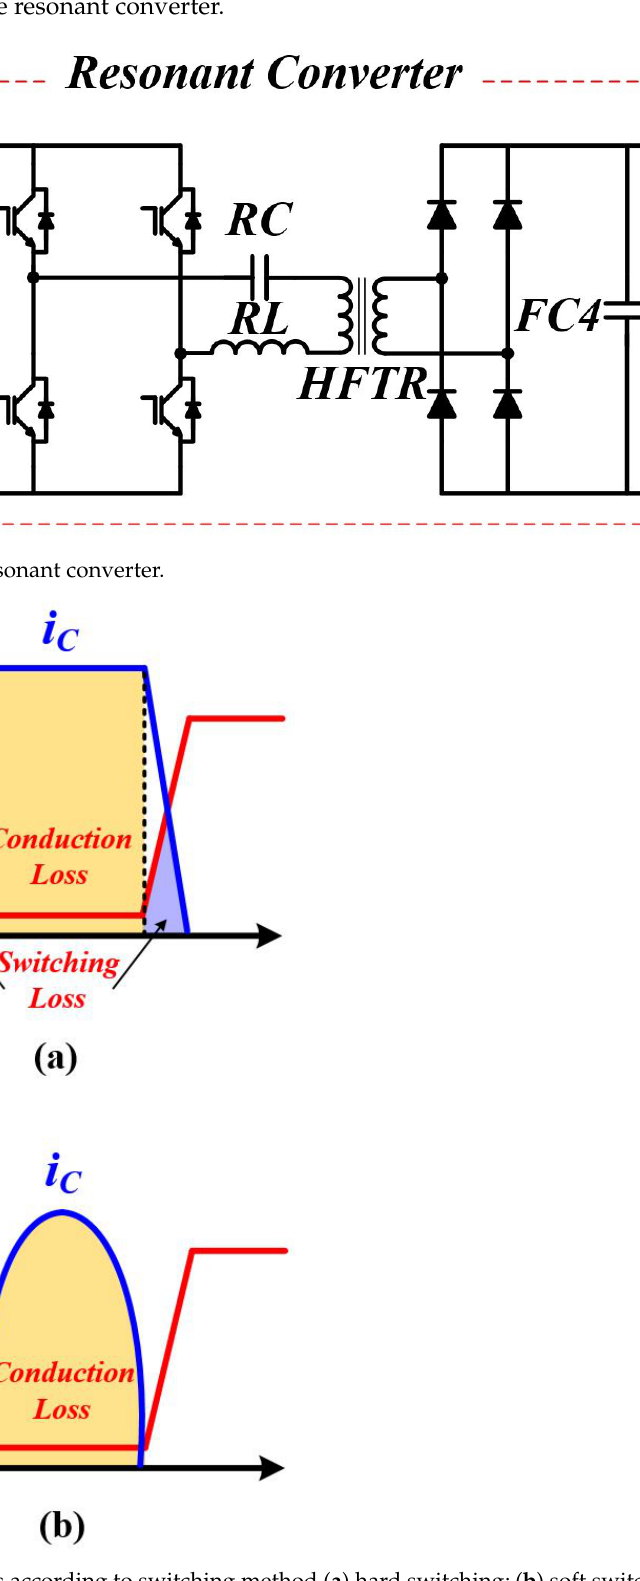
Figure 9. The losses according to switching method ( a ) hard switching; ( b ) soft